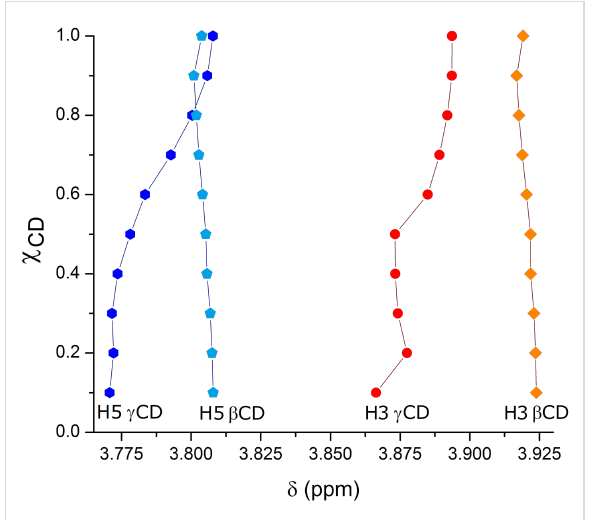
Figure 2: Chemical shift variation for the H3 and H5 protons of β -CD and γ -CD while performing the continuous variation method: [CD] + [aescin] = 10 mM. See Figure 9 for 1 H labelling. Full lines connecting the experimental points are for indicative purposes only.